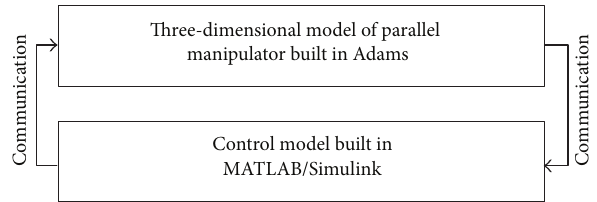
Figure 4: Structure of Adams and MATLAB cosimulation.